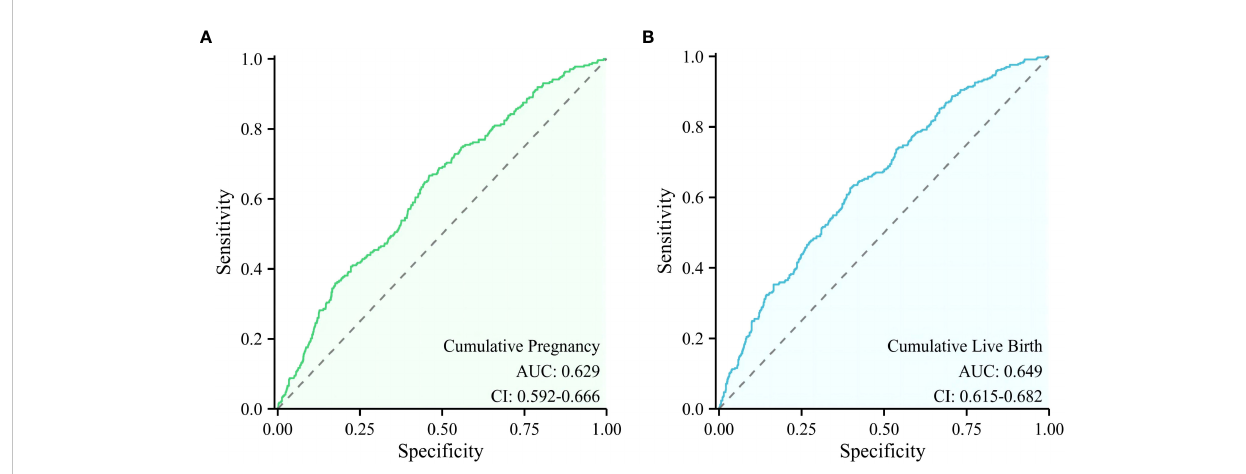
FIGURE 2 ROC curve of the models with the highest predictive value for cumulative pregnancy and cumulative live birth. (A) A model for predicting cumulative pregnancy, (B) A model for predicting cumulative live birth.